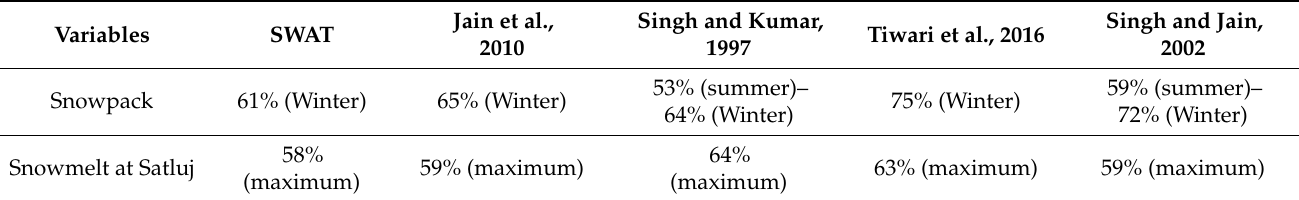
Table 3. Validation of modeled snowpack and snowmelt with respect to referenced datasets. Variables